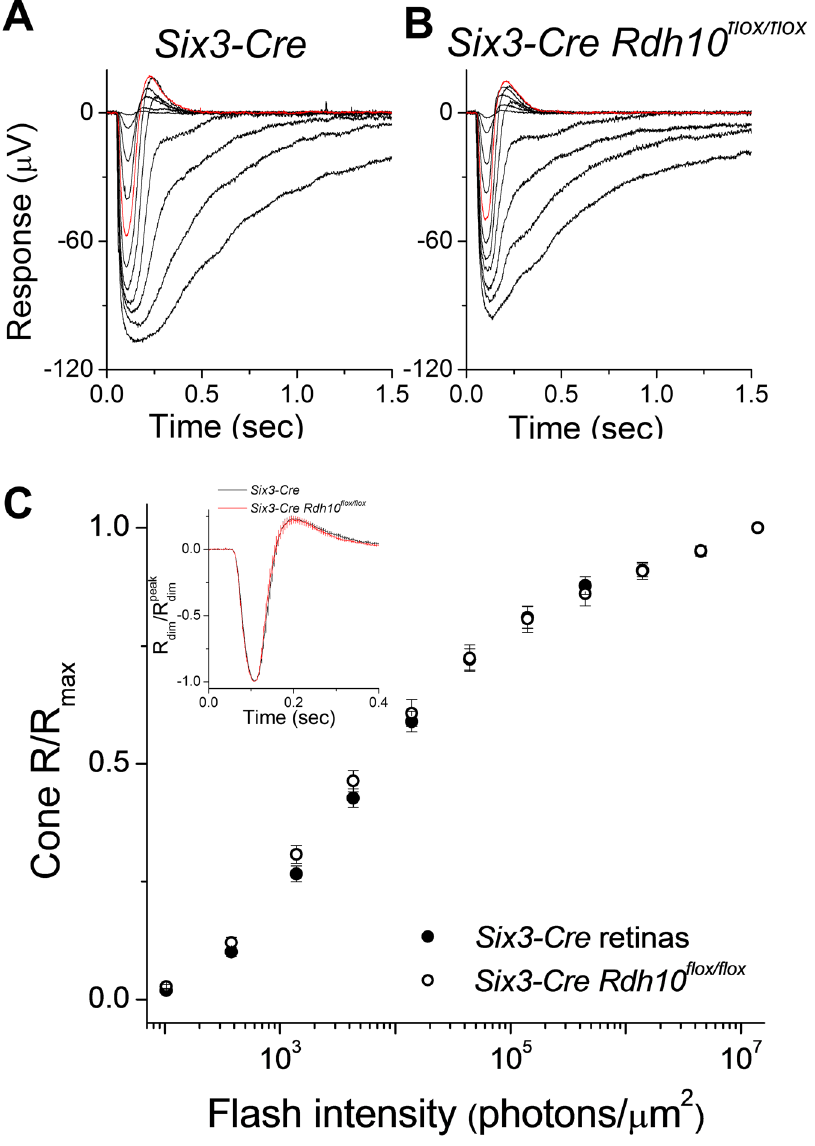
Figure 6. Deletion of RDH10 in the entire retina does not affect cone responses. Representative transretinal cone responses from ( A ) Six3-Cre control, and ( B ) Six3-Cre Rdh10 flox/flox retinas. Red traces: responses to a 1.4 × 10 4 photons/ μ m 2 test flash. ( C ) Normalized cone intensity-response curves of Six3-Cre control (n = 9, filled symbols) and Six3-Cre Rdh10 flox/flox (n = 8, open symbols) retinas. Inset: normalized cone dim flash responses from Six3-Cre control (n = 9, black trace) and Six3-Cre Rdh10 flox/flox (n = 8, red trace) retinas. All mice were in Gnat1 − / − background to facilitate cone